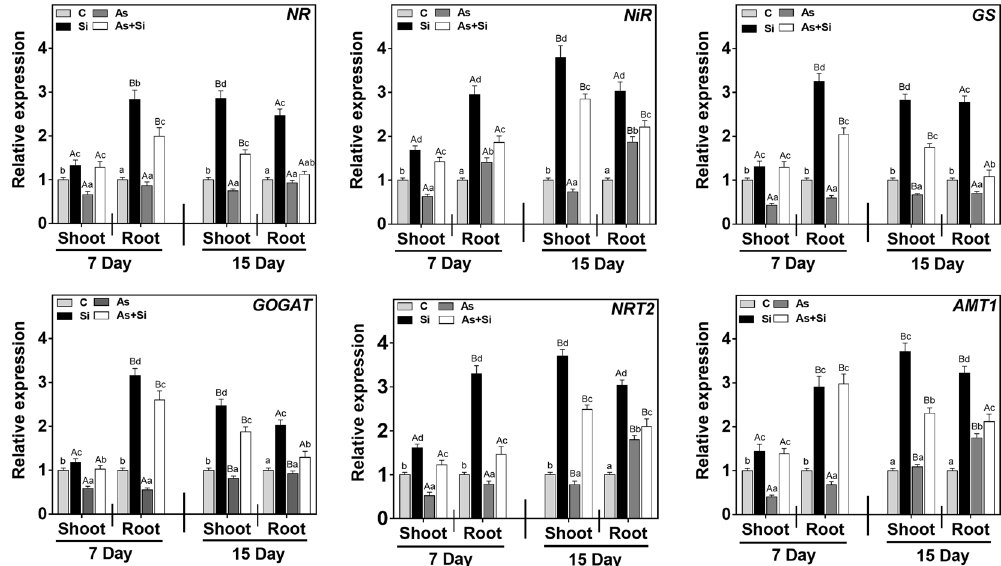
Figure 3. Differential expression of nitrogen absorption and assimilation related genes indicate their role under As and Si exposure in shoot and root of Oryza sativa var. IR64 at 7 and 15 d. Figure shows relative expression profile of six differentially regulated genes (nitrate reductase ( NR ), nitrite reductase ( NiR ), glutamine synthetase ( GS ), glutamate synthase ( GOGAT ), high affinity nitrate transporter protein ( NRT2 ) and high affinity ammonium transporter protein ( AMT1 ). All values are means of three replicates (n = 3, ± SD) and repeated twice. Different letters indicate the significant mean difference ( p < 0.05) between each treatment. The small latter (i.e. a, b, c and d) indicates the significant difference between treatment in same tissue type while capital latter (i.e. A and B) indicates the significant difference between duration among the same treatment in same tissue type. The endogenous actin gene of rice was used to normalize the genes relative to